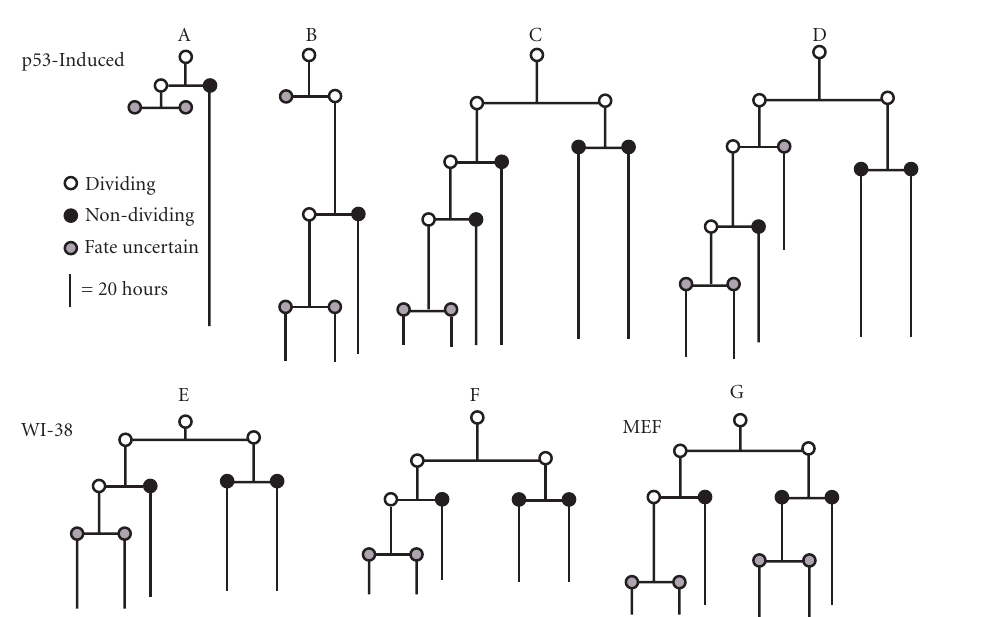
Figure 3: Division lineages for p53-expressing fibroblasts. Shown are examples of characteristic asymmetric cell kinetics lineages observed in time-lapse analyses of p53-inducible cells (line Ind-8; 26) grown under inducing conditions (A–D) and presenescent human and murine embryonic fibroblast cell strains grown under routine culture conditions. (E) and (F), WI-38 cells at passage 18 and 26, respectively; (G), wtMEFs at passage 6. Lineages are uneven at end because cell bodies do not indicate passage of time. “Fate uncertain” indicates that a cell either migrated from the field of view or was not observed for sufficient time to assign its division state with confidence. These occasional symmetric divisions in otherwise simple asymmetric lineages may indicate variability in transit cell maturation mechanisms. Whereas, the predominant transit cell division number (TDN) for p53-induced“transit cells”in culture is zero ( i.e. , terminal arrest without division), at a low frequency,transit cells may mature to a TDN of 1 ( i.e. ,a single division followed by terminal arrest of both